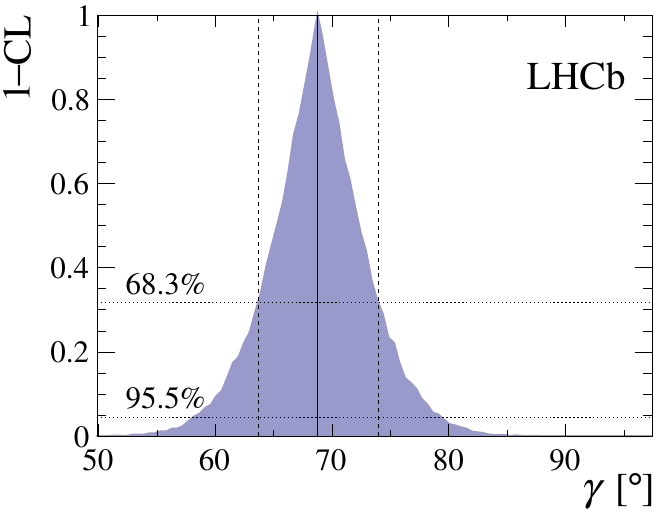
Figure 7 . Confidence limits for the CKM angle γ obtained using the method described in ref. [44].